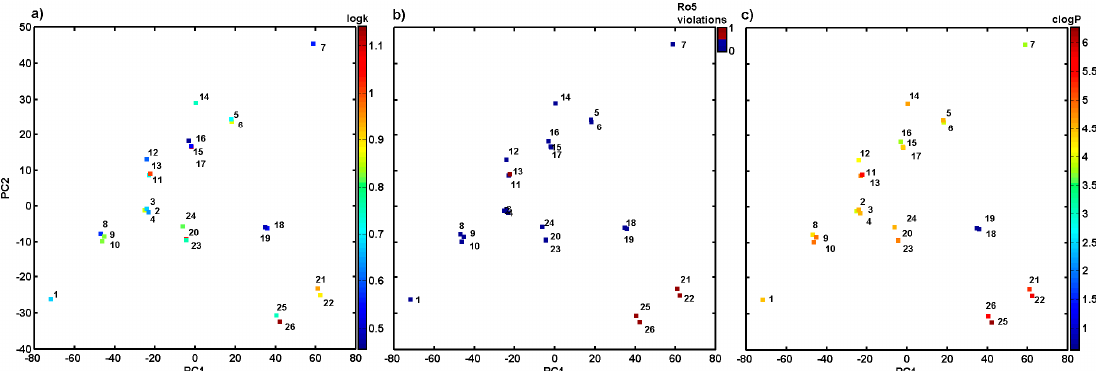
Figure 3. Projection of derivatives 1 – 26 on plane defined by first vs. second principal component with: log k ( a ), number of Ro5 rule violations ( b ) and calculated in Sybyl-X lipophilicity ( c ). Colours code values of experimental lipophilicity, Ro5 violations and theoretical lipophilicity.